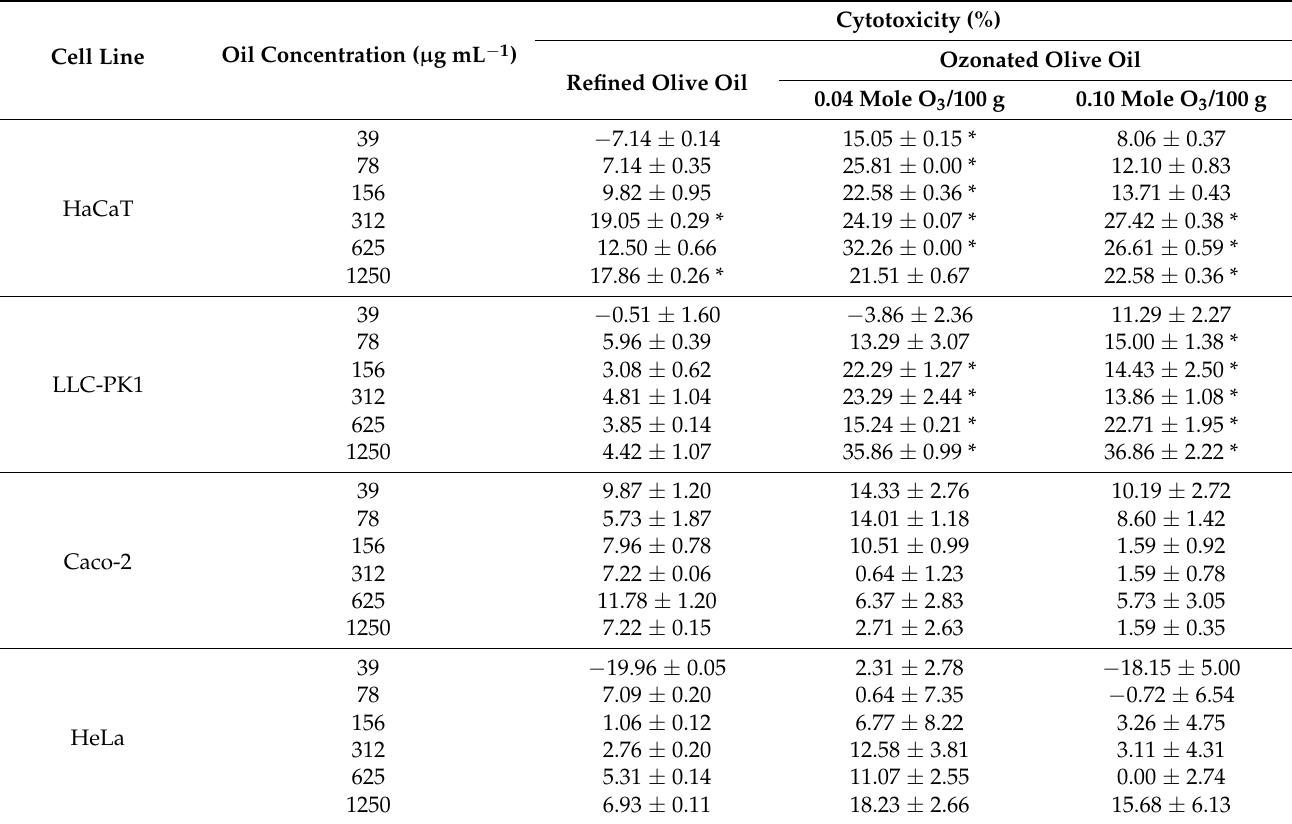
Table 5. Cytotoxic action of refined and ozonated olive oils towards normal (HaCaT and LLC-PK1) and cancerous (Caco-2 and HeLa) cell lines after 24 h exposure as measured in the 3-(4,5-dimethylthiazolyl-2)-2,5-diphenyltetrazolium bromide (MTT) assay comparing to the cells non-exposed to the olive oils. Each value represents the mean of four individual replications ±